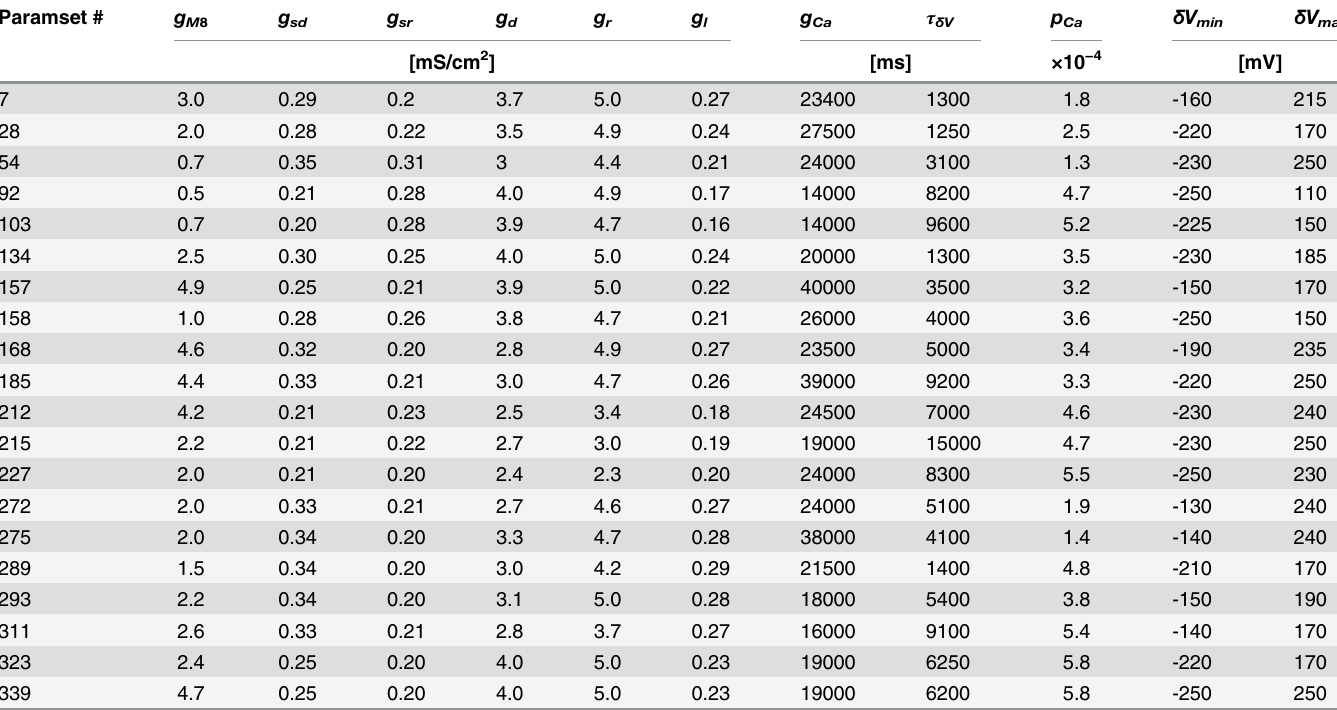
Table 1. Values of free parameters that reproduce satisfactorily both the dynamic and static responses of cold sensitive nerve endings. Paramset # g M